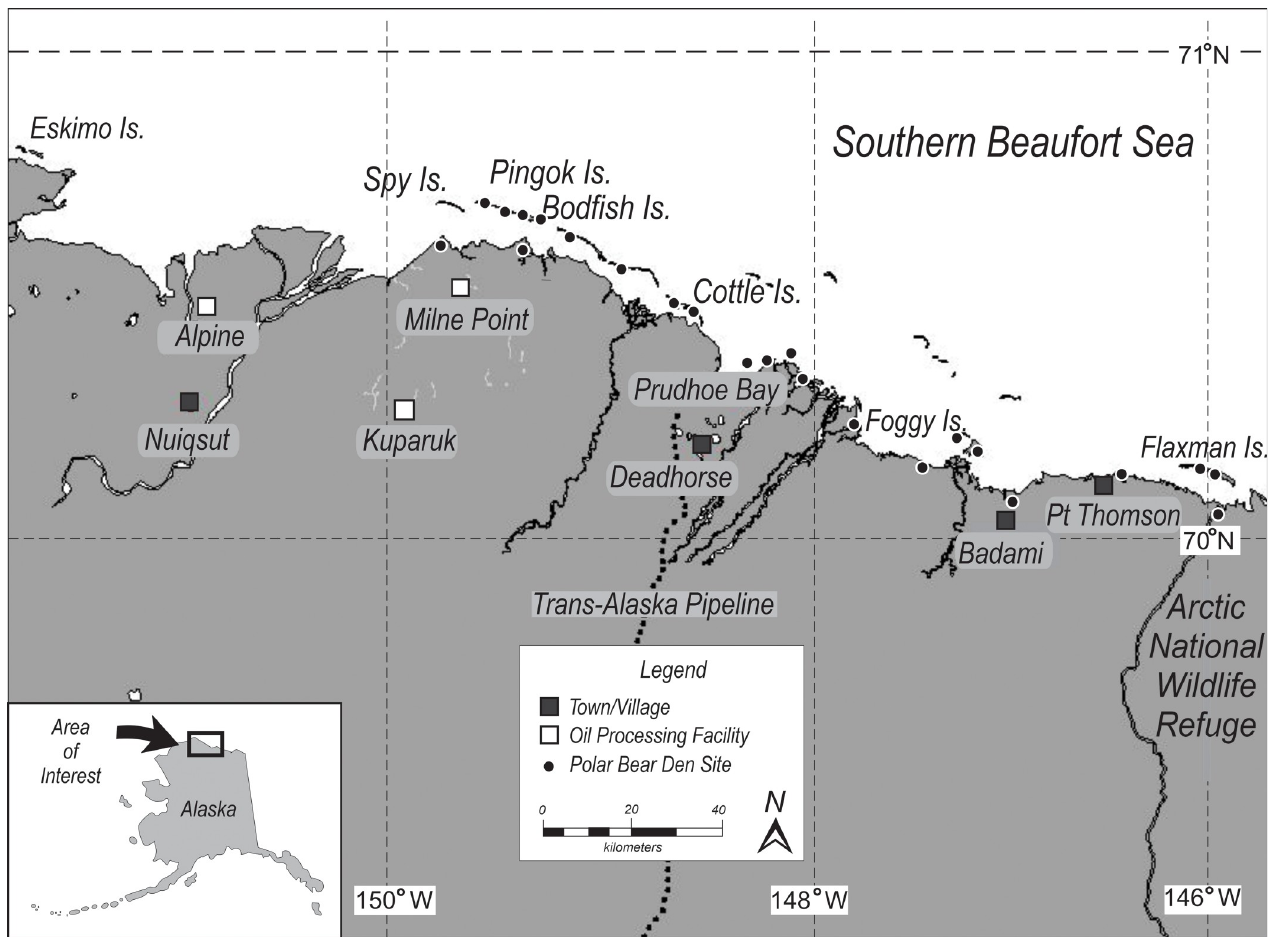
Fig 1. Study area where FLIR aerial surveys and ground truthing of polar bear den detection surveys were conducted in northern Alaska,